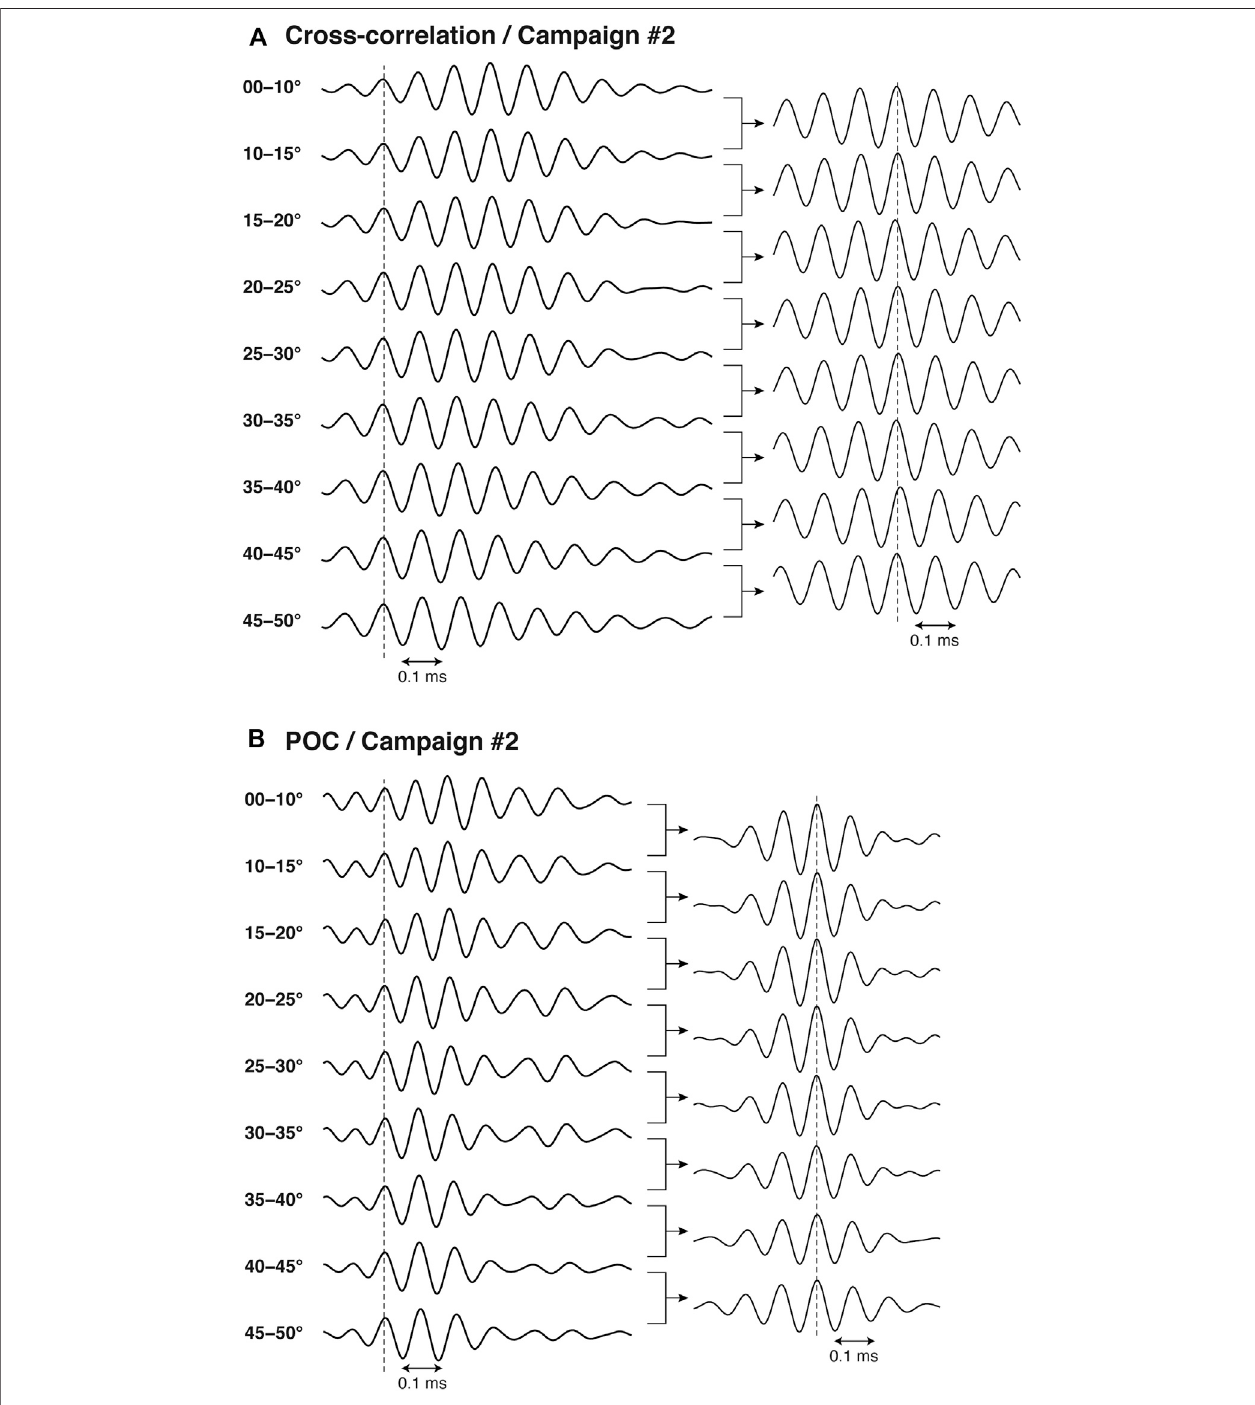
FIGURE5| Anotherexampleoftemplatesusing (A) conventionalcross-correlationor (B) POC,createdforacampaignconductedinabenchmarkoffthenortheast Japan, located ∼ 2,050 m in water depth. Graphs in the left and right columns are the templates and the cross-correlation between adjacent templates, respectively.